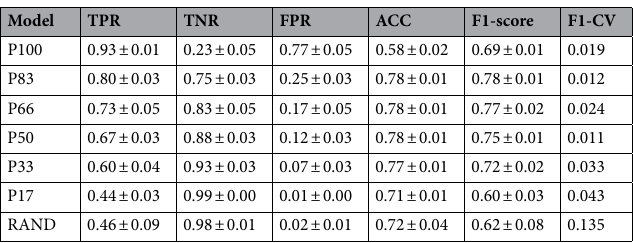
Table 2. Performance metrics for different CXR